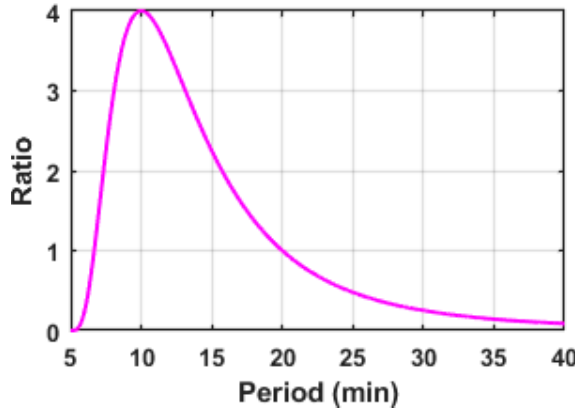
Figure 4. The relation between period and amplitude for τ equals 300 s.